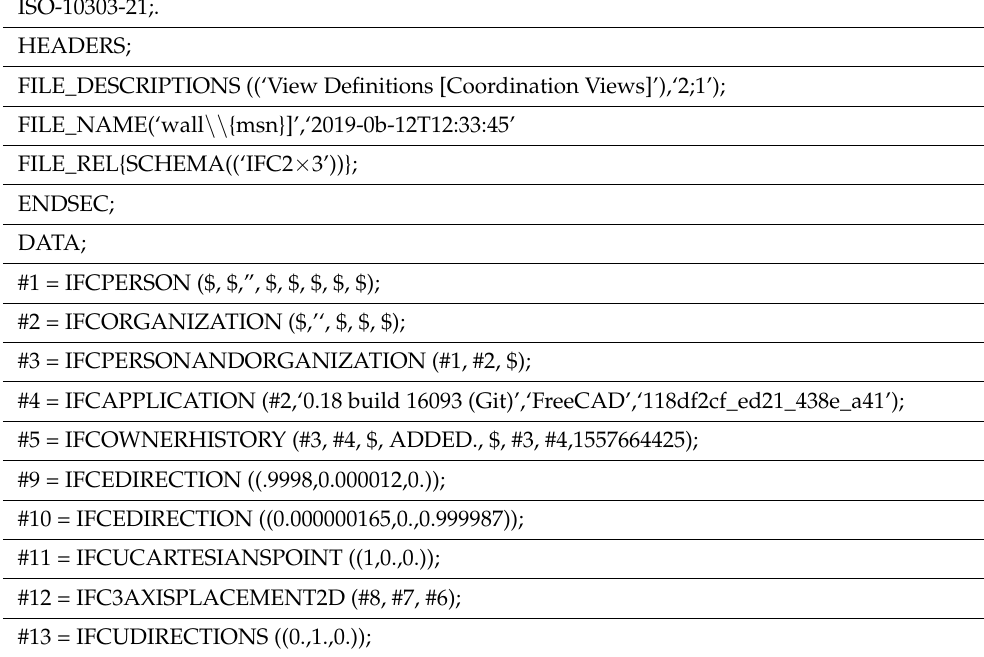
Table 5. Basic Form of IFC